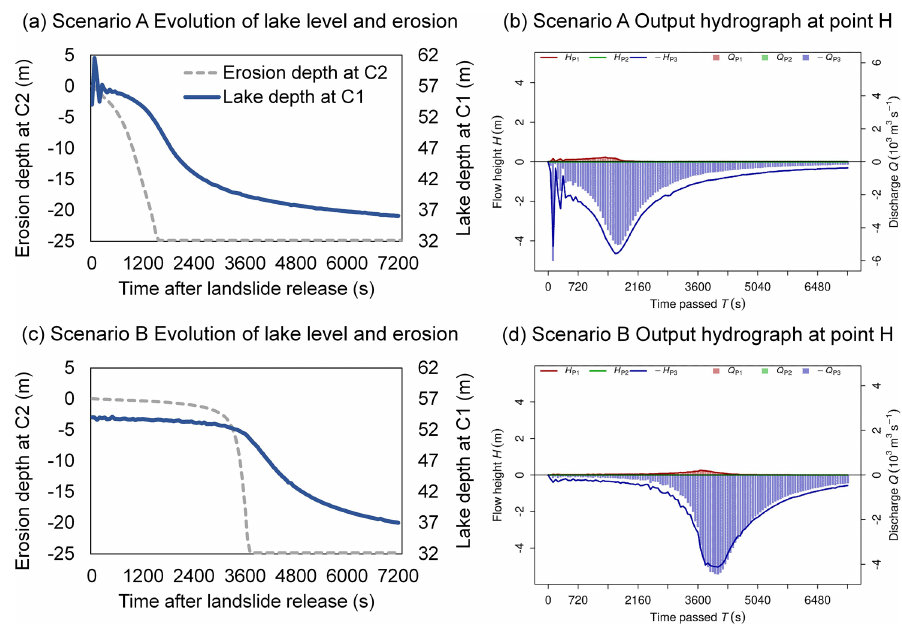
Figure 9. Dam breach as simulated with r.avaflow. (a) Scenario A, evolution of lake level and the erosion channel. (b) Scenario A, output hydrograph. (c) Scenario B, evolution of lake level and the erosion channel. (d) Scenario B, output hydrograph. Locations of the points C1, C2, and H are indicated in Figs. 5 and 11. In the output hydrographs, H means flow height, and Q means discharge. The subscript P1 refers to phase 1 (rock), P2 to phase 2 (not existent in this case), and P3 to phase 3 (water). Fluid discharge and flow height are plotted in the negative direction for better